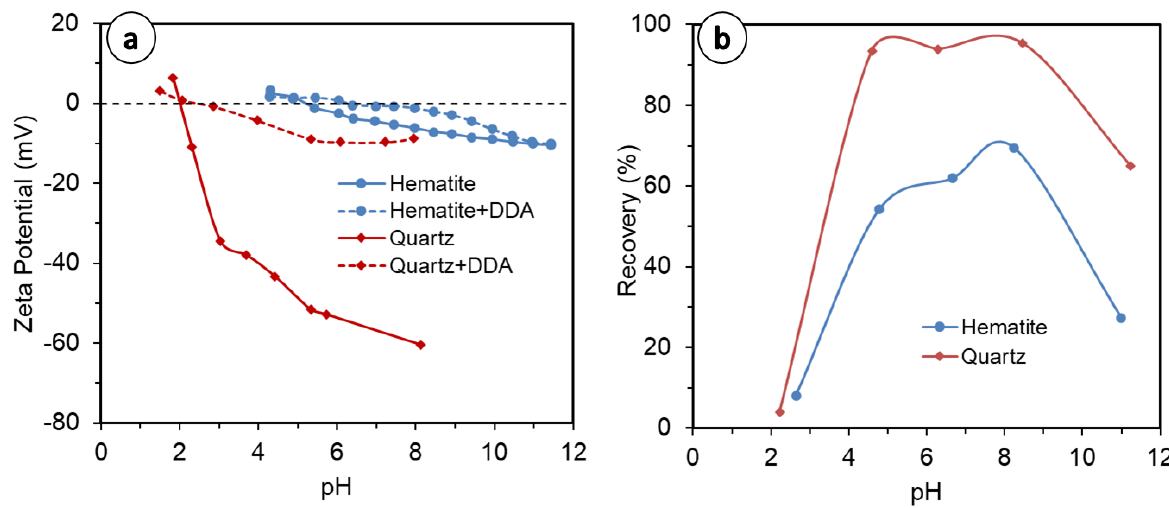
Figure 3. ( a ) Zeta potential of quartz and hematite, bare and treated with DDA, redrawn from [50,51]; ( b ) Recovery of quartz and hematite in DDA system as a function of pH, redrawn from [52].